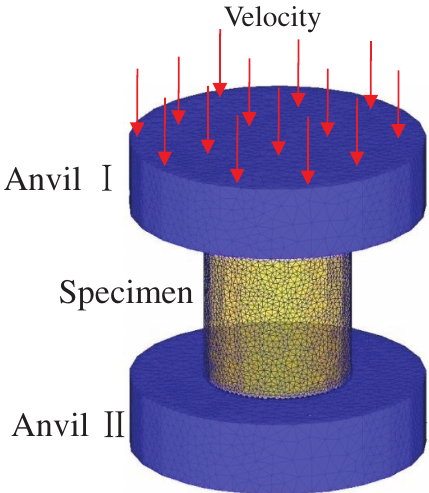
Figure 10: The finite element model for the simulated isothermal compression tests of 3Cr20Ni10W2 heat-resisting